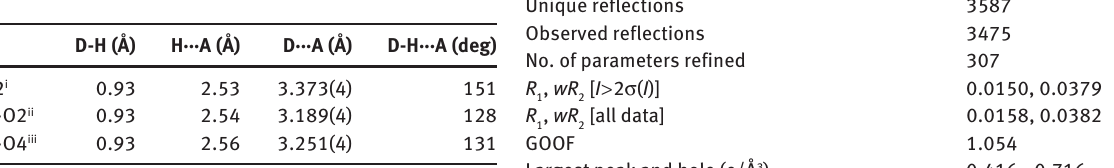
Table 3 H-bonding geometry parameters ( Å and deg) for the title